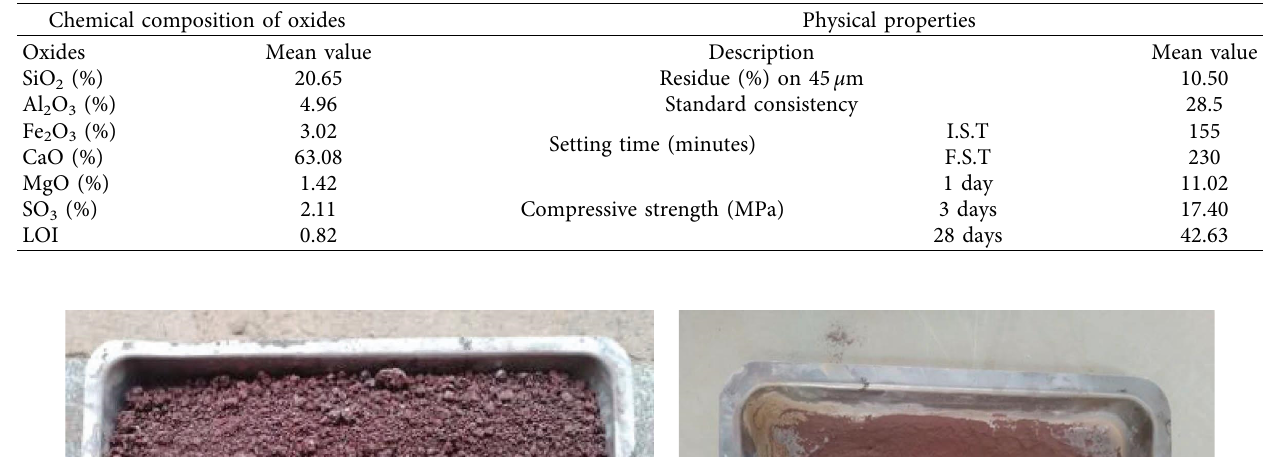
Table 2: Chemical and physical properties of cement used.